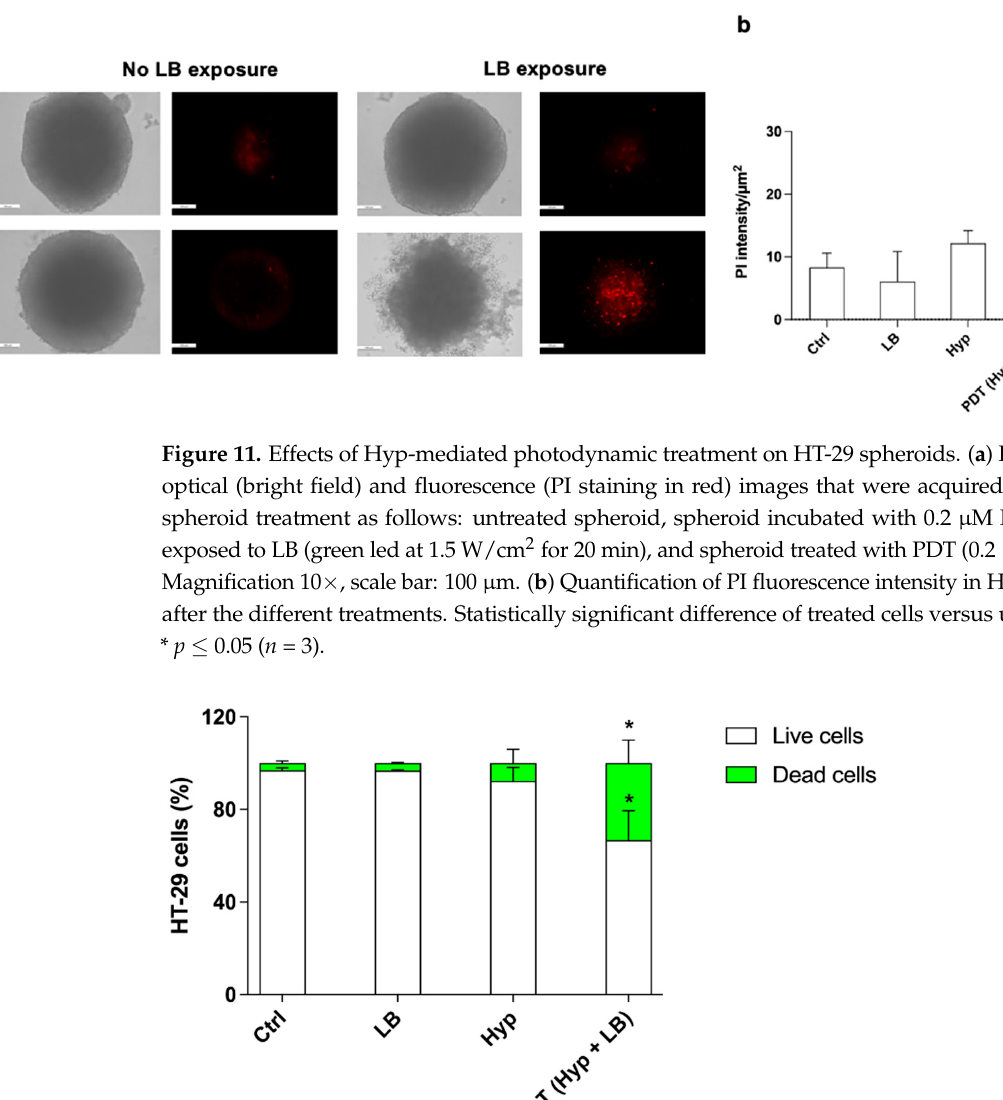
Figure 12. Cell death evaluation after Hyp-mediated photodynamic treatment in HT-29 spheroids. HT-29 spheroids were previously incubated with 0.2 µ M Hyp and then exposed to LB (green LED at 1.5 W/cm 2 for 20 min). Cell death was evaluated by flow cytometry using SYTOX™ green dead cell staining and expressed as cell percentage. Statistically significant difference versus untreated cells (Ctrl): * p ≤ 0.05 ( n =